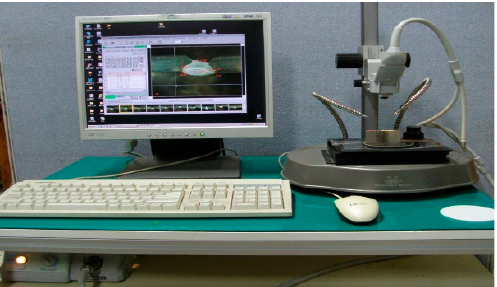
Figure 5. Schematic diagram of dilution ratio.